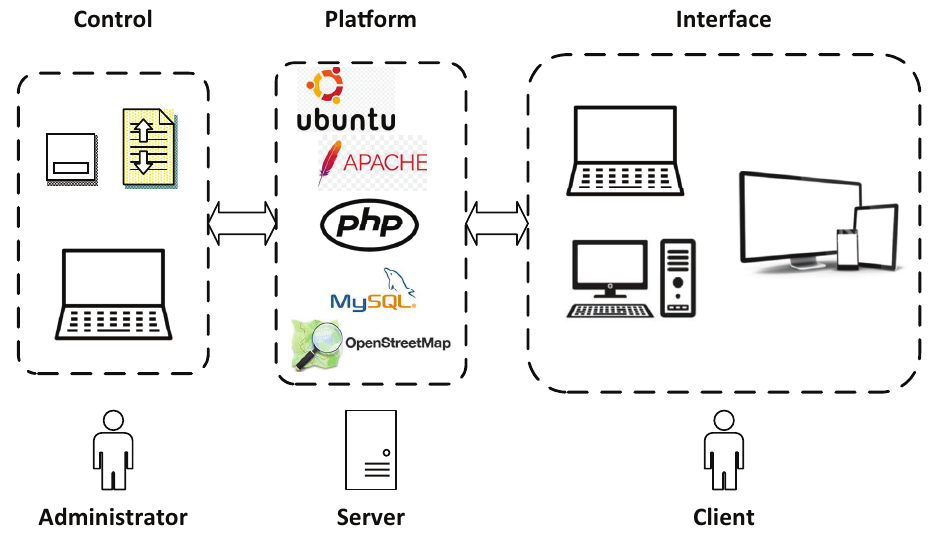
Figure 3. Operation